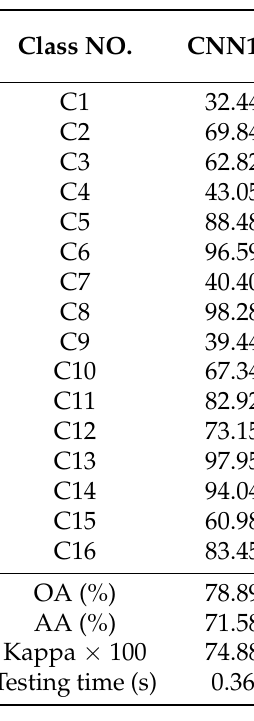
Table 8. Classification results for the PU dataset using 5% of the available labeled data. Class